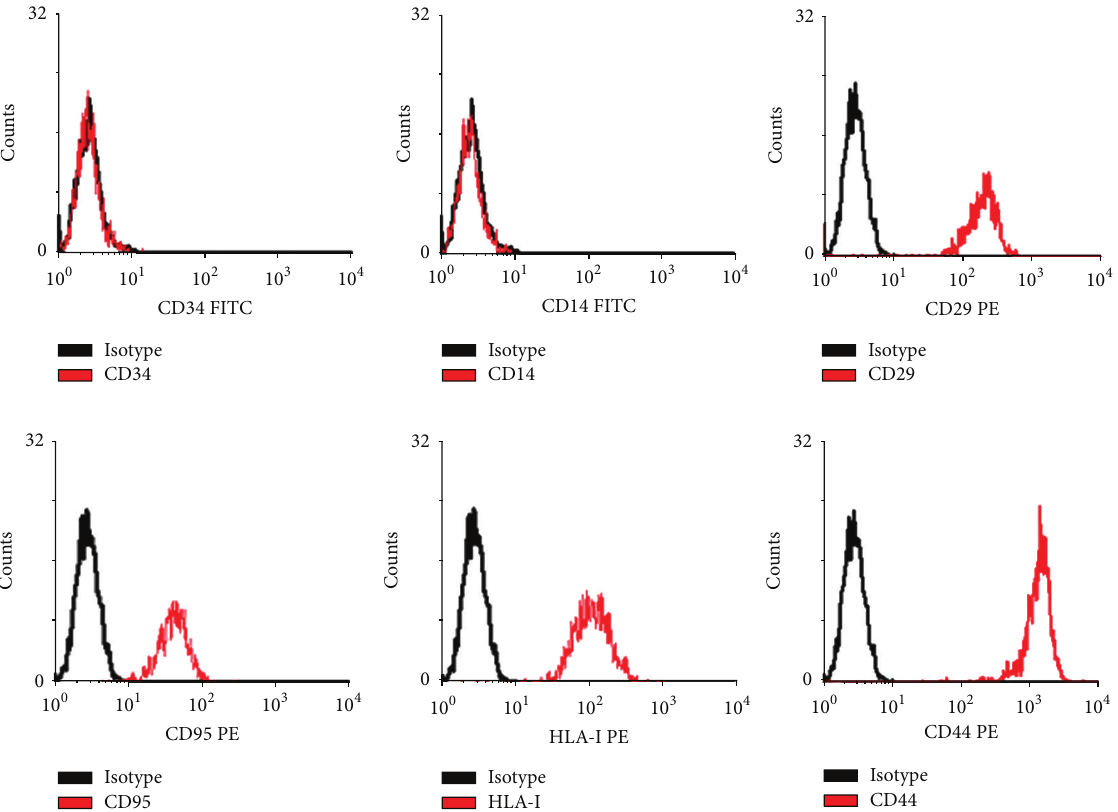
Figure 1: Identification of BMSCs by flow cytometry method. BMSCs were examined by flow cytometry for expression of discriminating BMSCs surface markers as described in Section 2. Shown in this set are representative findings for BMSCs: positive expression of CD29, CD95, HLA-I, and CD44, yet negative expression of CD34 and CD14 (𝑛 = 7) . The black lines represent BMSCs incubated with corresponding isotype antibody controls.